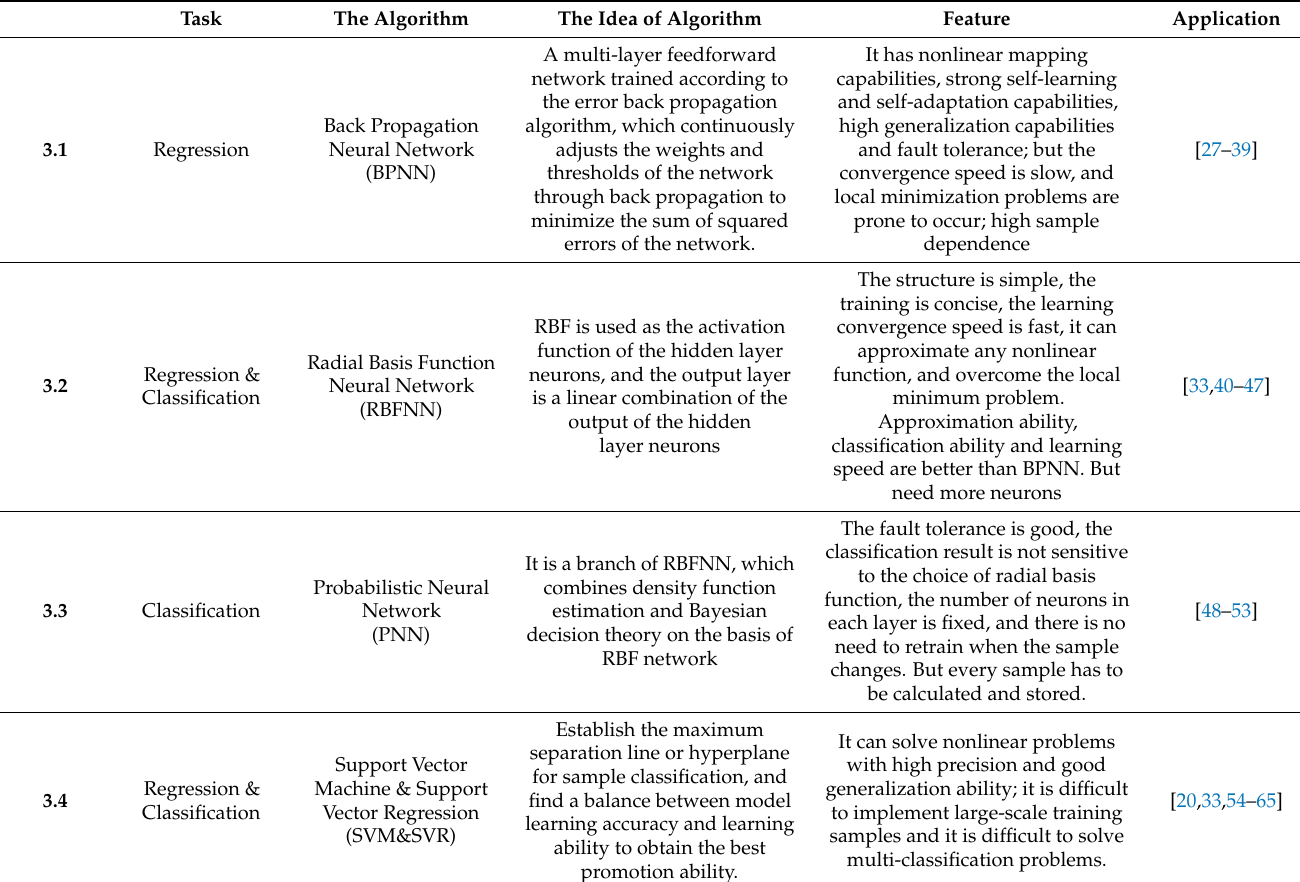
Table 2. The introduction of some common